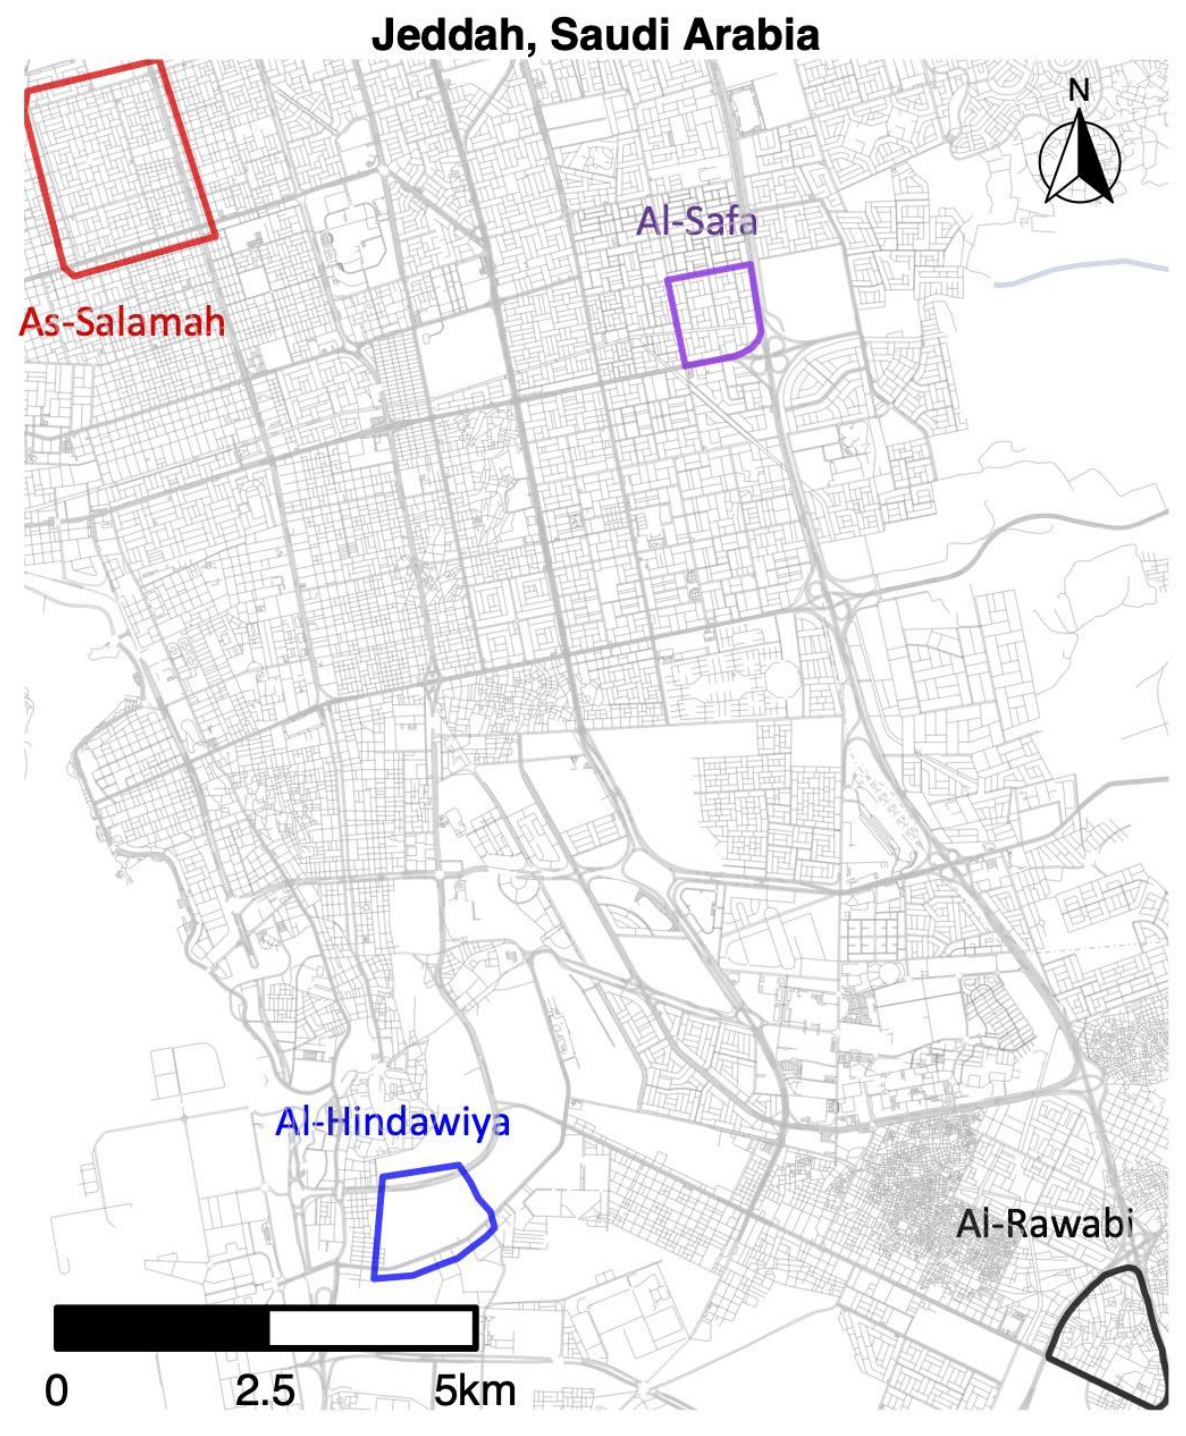
Figure 1. Map of Jeddah (western Saudi Arabia) showing the geographical location of the four districts where pre-release sampling occurred from December 2020 to April 2022.